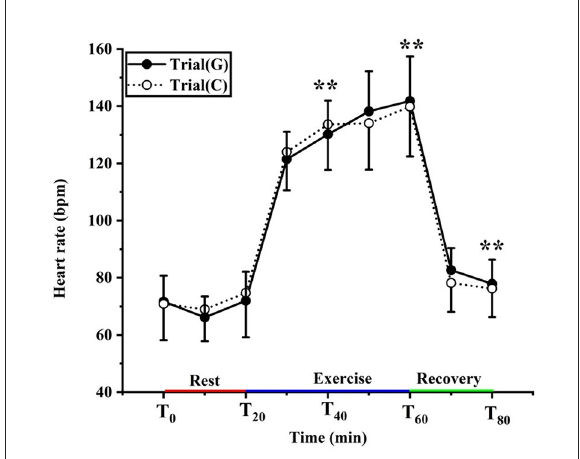
FIGURE5 Changing in heart rate in trial G (black) and trial C (white). Values are means ± SD. Bars represent standard deviations, ** P < 0.01, significant difference compared to T 0 .